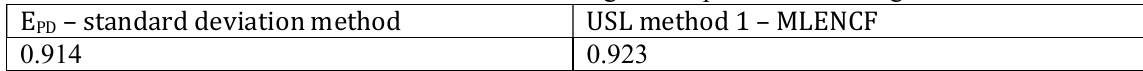
Table II.: E and USL Methods using 175 Experimental PD